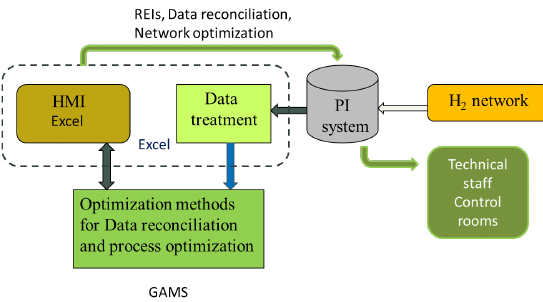
Figure 4. Block diagram of the data reconciliation and RTO showing the information flows and main components.